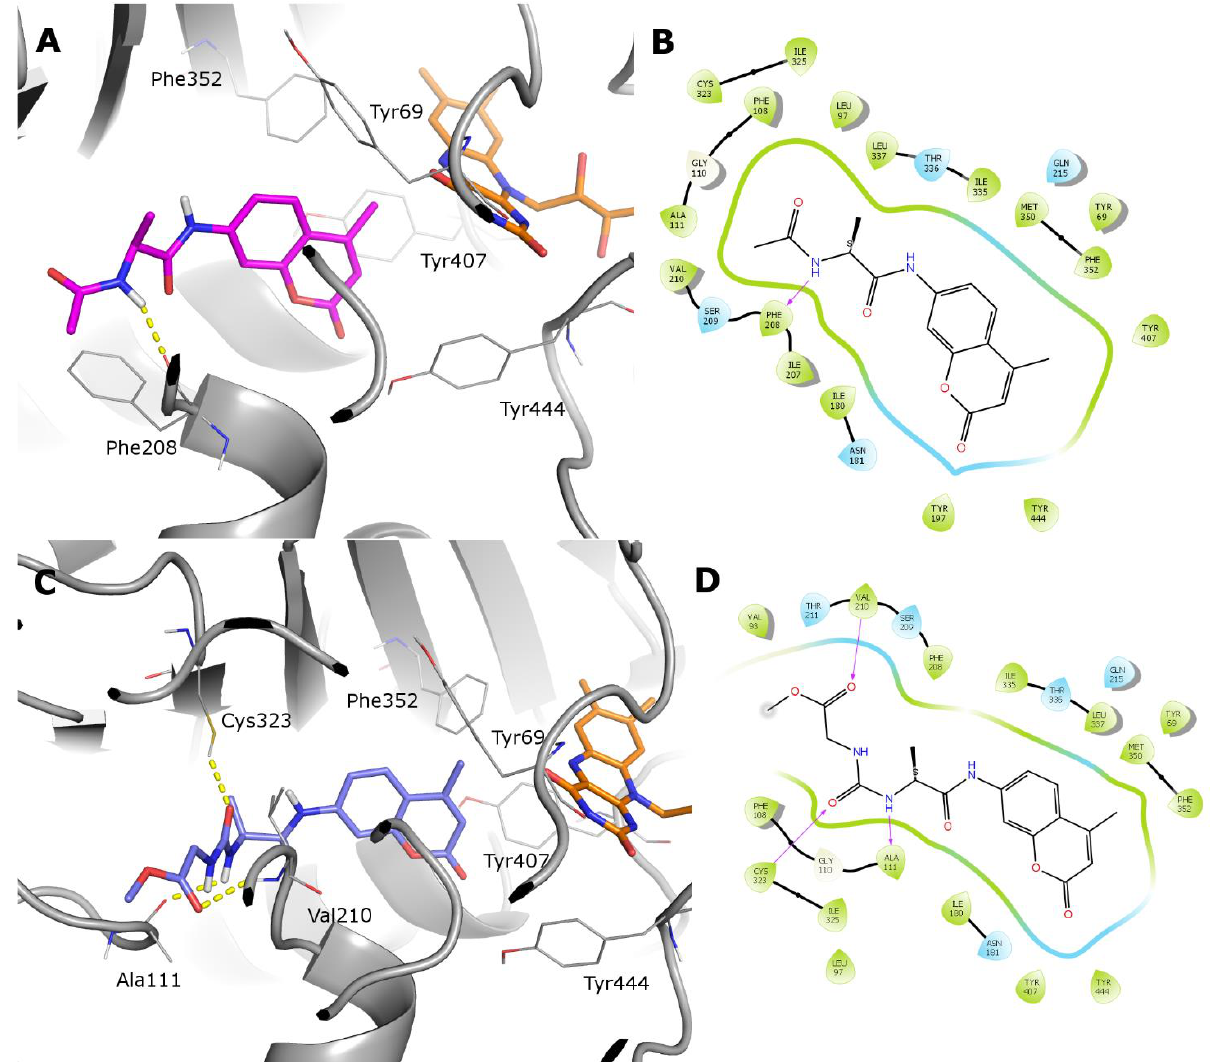
Figure 6. Panels ( A , C ) show the catalytic site of hMAO-A (grey cartoon) in complex with com- pounds 6 (magenta C atoms) and 16 (pale purple C atoms), respectively. Panels ( B , D ) show the corresponding 2D interaction diagrams.